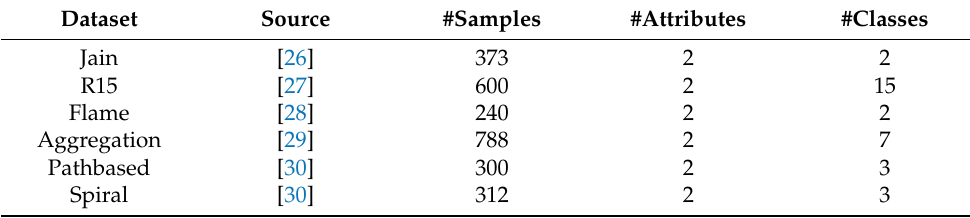
Table 1. Synthetic datasets.